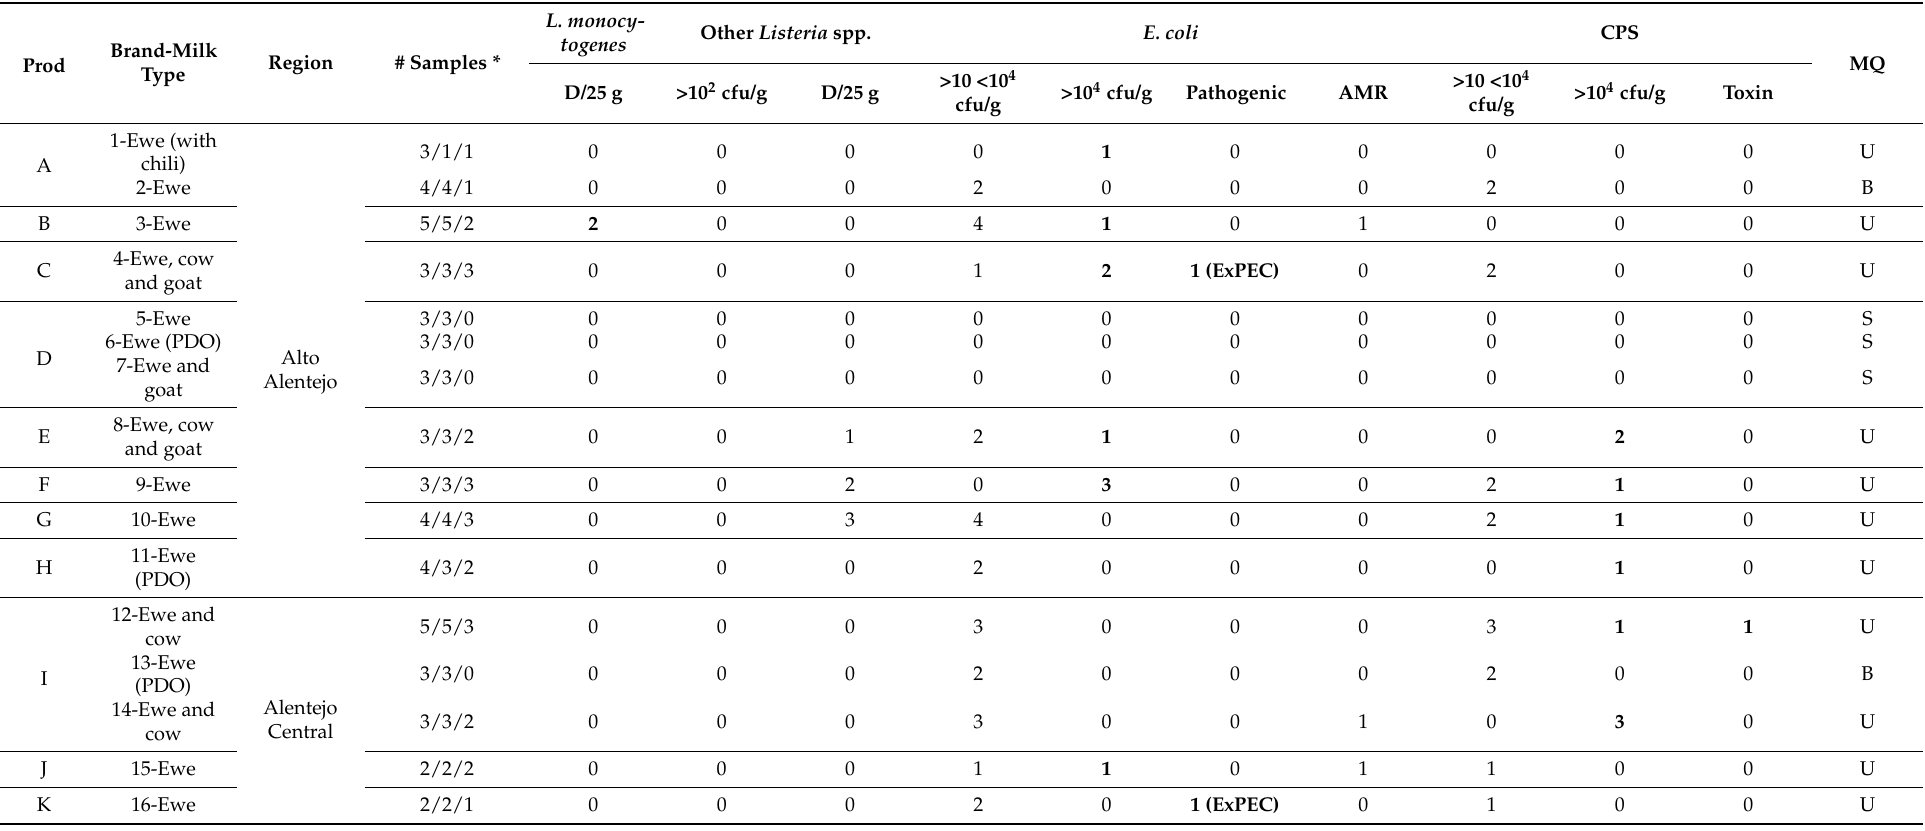
Table 3. Microbiological results by brand and